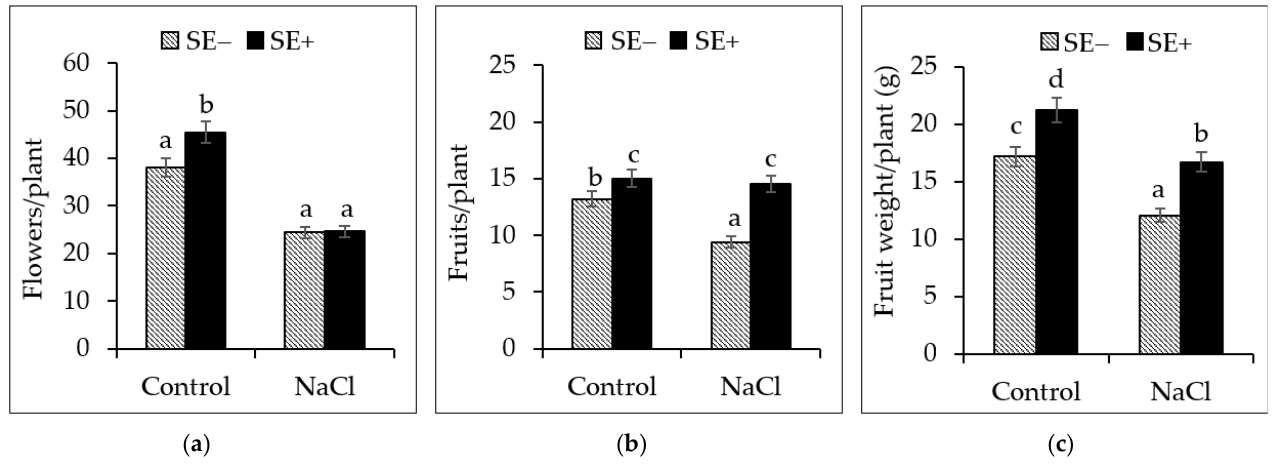
Figure 5. Productivity at harvest. ( a ) Number of flowers per plant, ( b ) number of fruits per plant, and ( c ) fresh weight of fruits per plant grown under normal conditions (Control) and salinity stress conditions (300 mM NaCl) with the application of the seaweed extract from P. gymnospora (0.2%; SE+) and without the extract (SE − ). Different letters indicate significant differences among treatments according to the least significant differences (LSD) mean comparison test ( p ≤ 0.001).